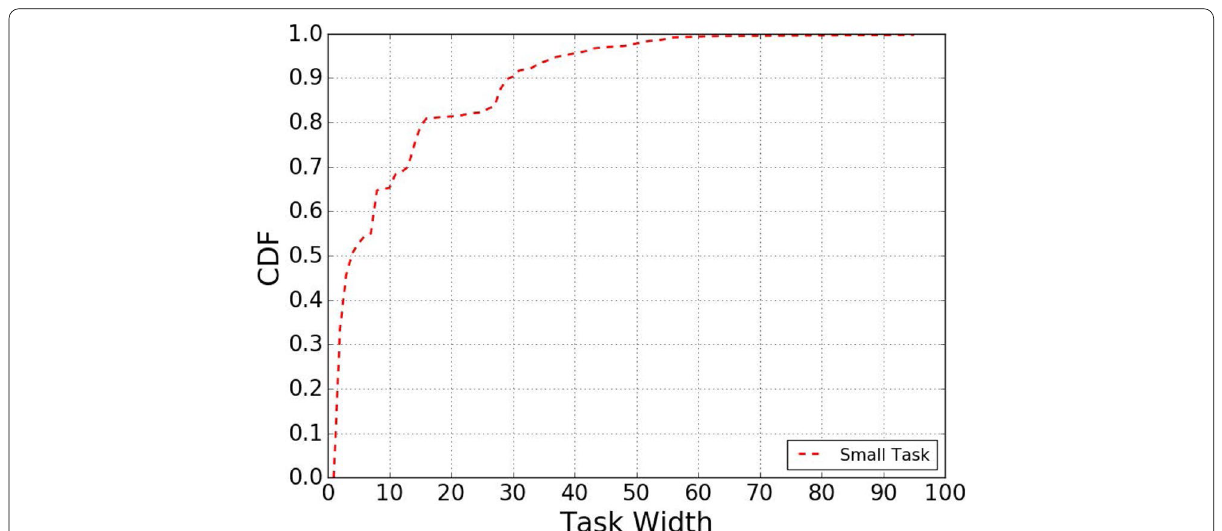
Fig. 2 CDF of task width